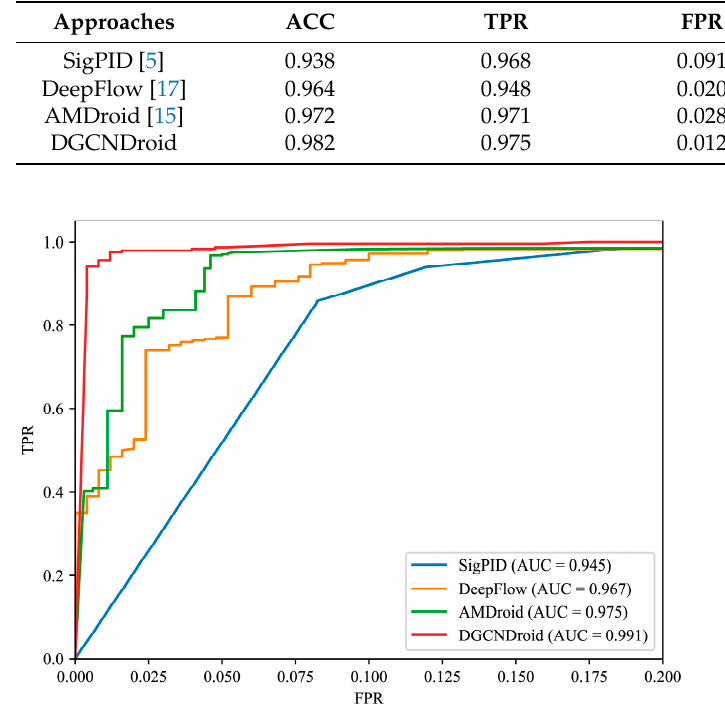
Figure 8. ROC curve of different methods.